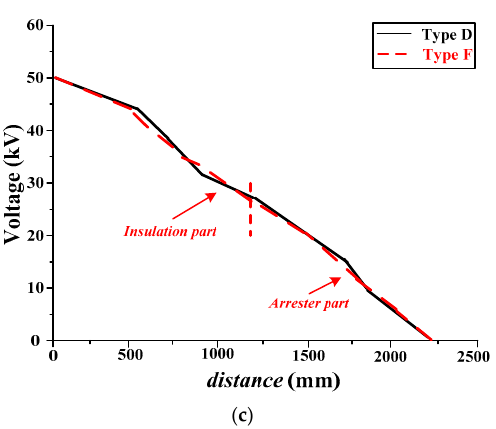
Figure 9. Voltage distributions of the test specimens under different icing conditions. ( a ) d = 5 mm; ( b ) d = 15 mm; and ( c ) d = 25 mm.